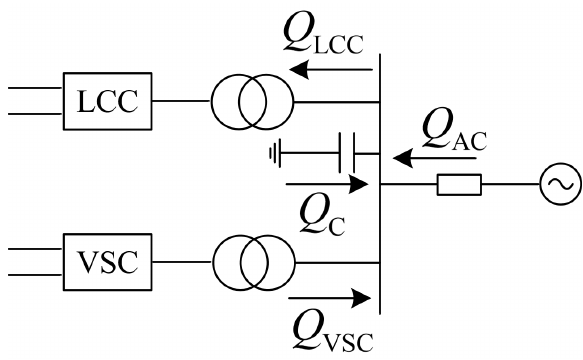
Fig. 3. Schematic diagram of reactive power exchange on the inverter side.